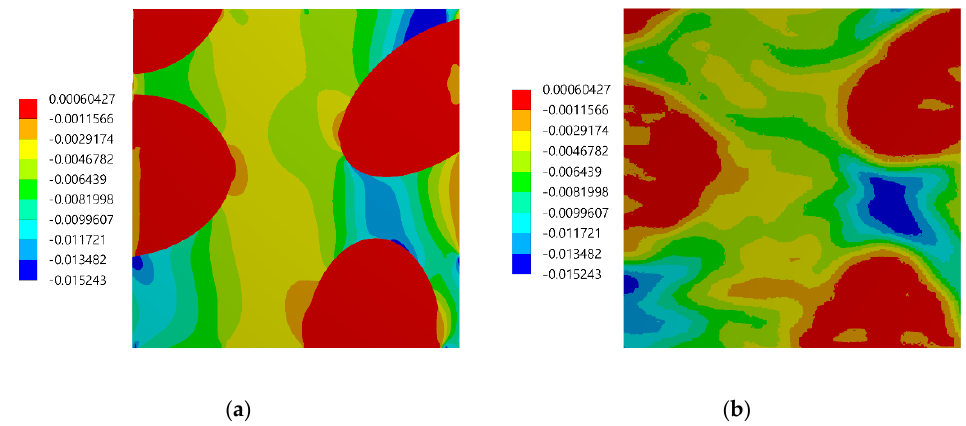
Figure 9. Distribution of the ε xx strain: ( a ) FE reference solution, ( b ) DIC analysis.